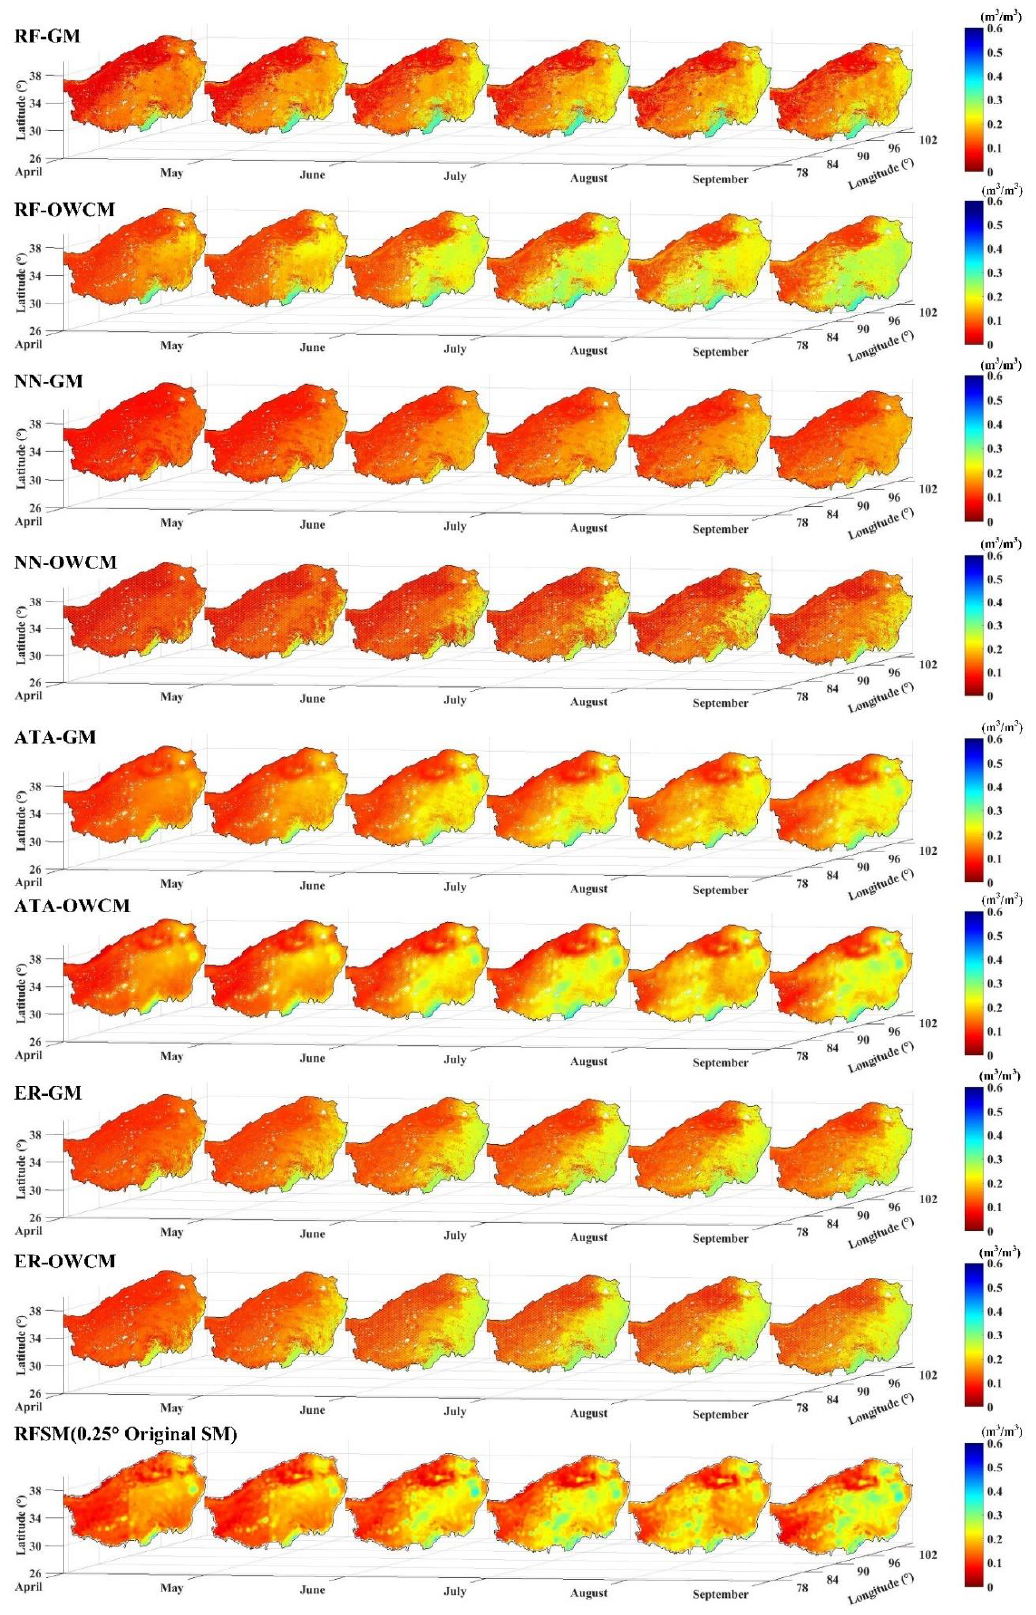
Figure 5. The spatial distribution of the monthly averaged SM products over the QTP during the 2016 unfrozen season, calculated from the corresponding GM-/OWCM-derived fine-RES SM, along with the original RFSM.